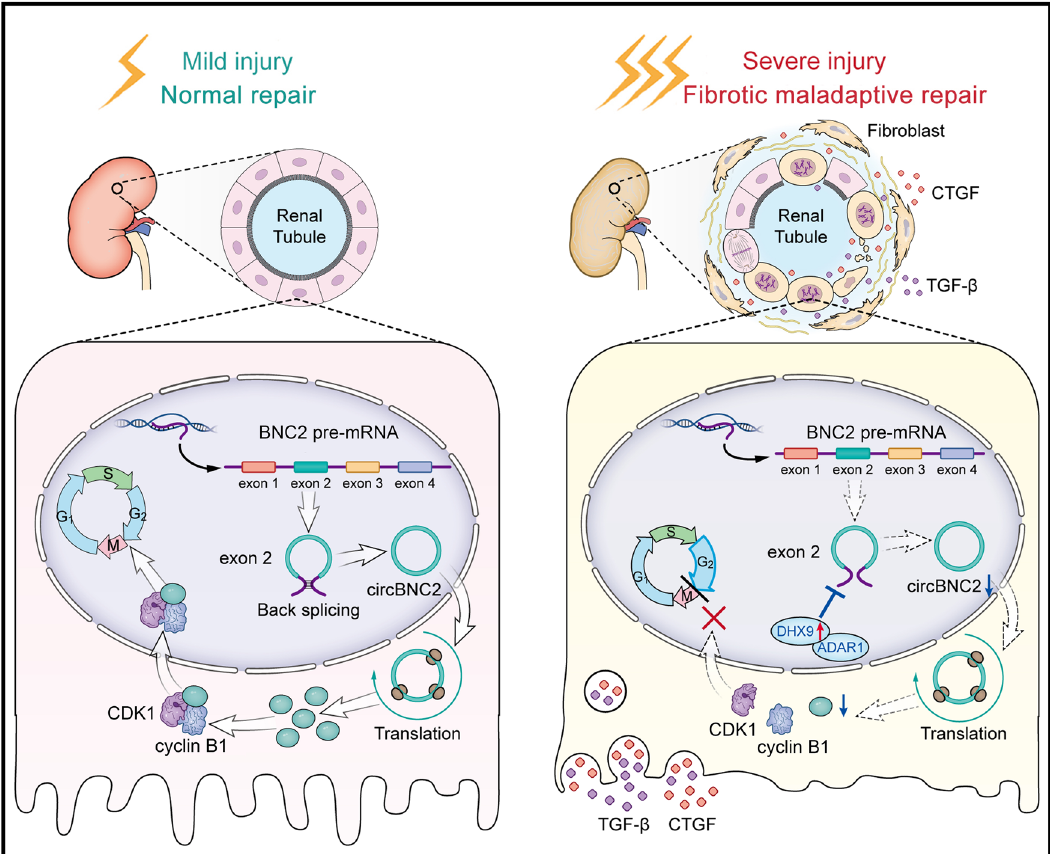
Fig.8|ProposedmodelforcellcycleregulationbycircBNC2. AproteinencodedbycircBNC2isdysregulatedinsevereinjuredepithelialcells,resultingintheG2/Mcell cycle arrest and the subsequent fi brotic maladaptive